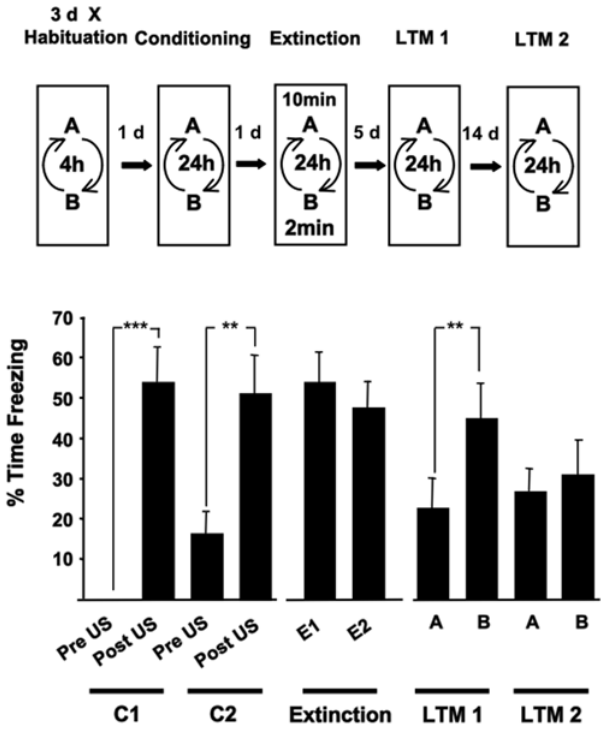
Figure 1. 10 min exposure to a conditioned context induced the extinction of a selectively recalled fear memory. Repeated measures ANOVA revealed significant effects of the training and test phases on freezing behaviour (F (4.329, 47.618) =11.355, P =0.000, e =0.481). Rats (n=12) presented with a single footshock (US) in two distinct contexts (A and B) 24 hrs apart (C1 and C2) showed robust freezing behaviour in the post US period and during the first 2 min of exposure to the conditioned contexts during the two extinction training sessions (E1 and E2) two days later. All rats experienced a 2 min re-exposure to one of the conditioned contexts and a 10 min exposure to the other conditioned context in a counterbalanced manner. Rats re- exposed to the conditioned contexts 5 days later (LTM 1) showed less freezing in the context in which they experienced a 10 min exposure (A), than in the context that they had been exposed to for 2 min (B) during extinction training. At a further test 3 weeks after conditioning (LTM 2) the rats showed low levels of conditioned fear in both contexts. Results are presented as the Mean 6 S.E.M. * P , 0.05, ** P , 0.01, *** P ,